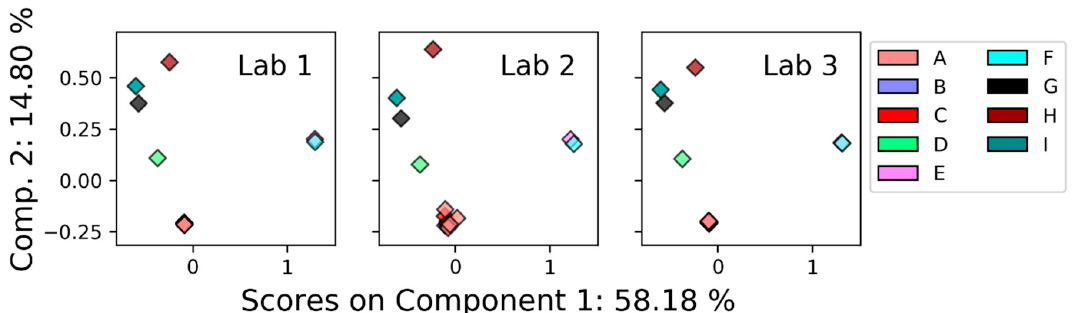
Figure 2. PCA scores for the three labs reporting NMR data.